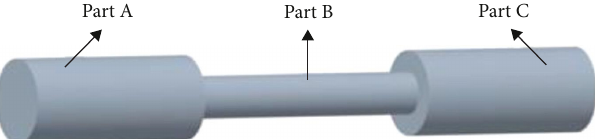
F IGURE 10: Movement in a horizontal straight tube with 25 mm inner